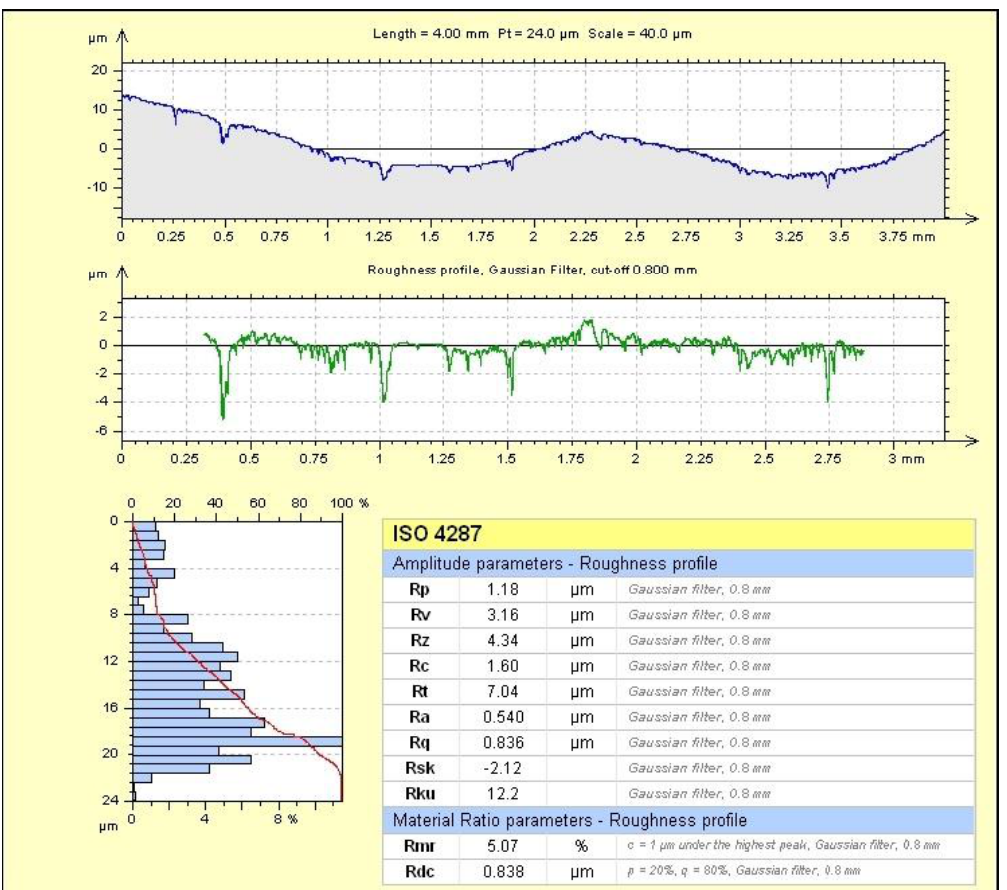
Figure 2. Surface roughness measurement.